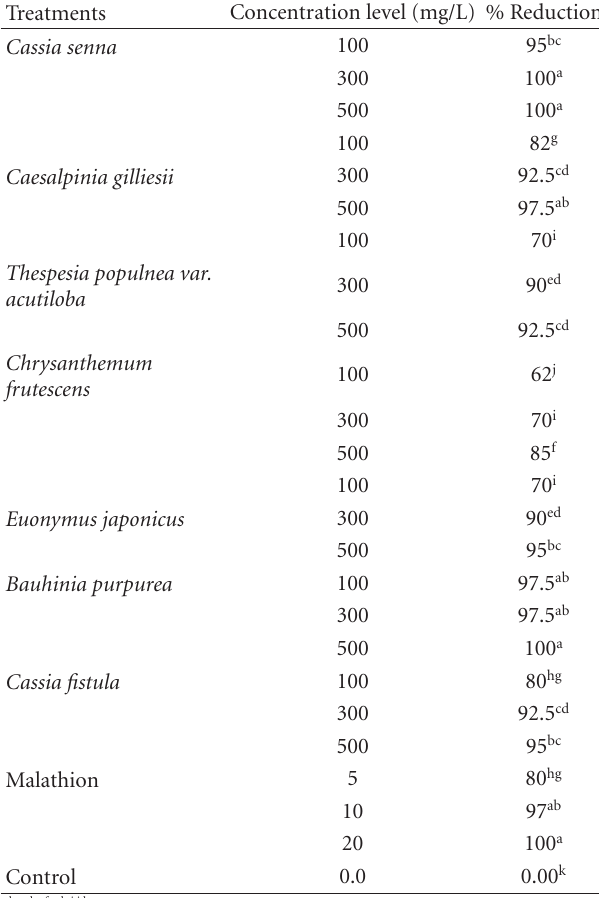
Table 1: E ff ect of the tested plant extracts and malathion on prog- eny of T. granarium